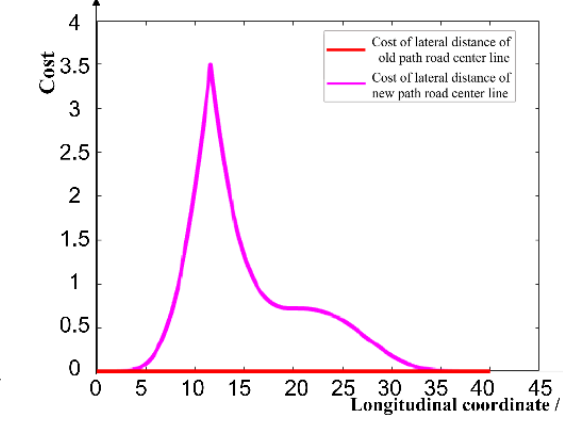
Figure 8. Path cluster generation for simulation scenario.